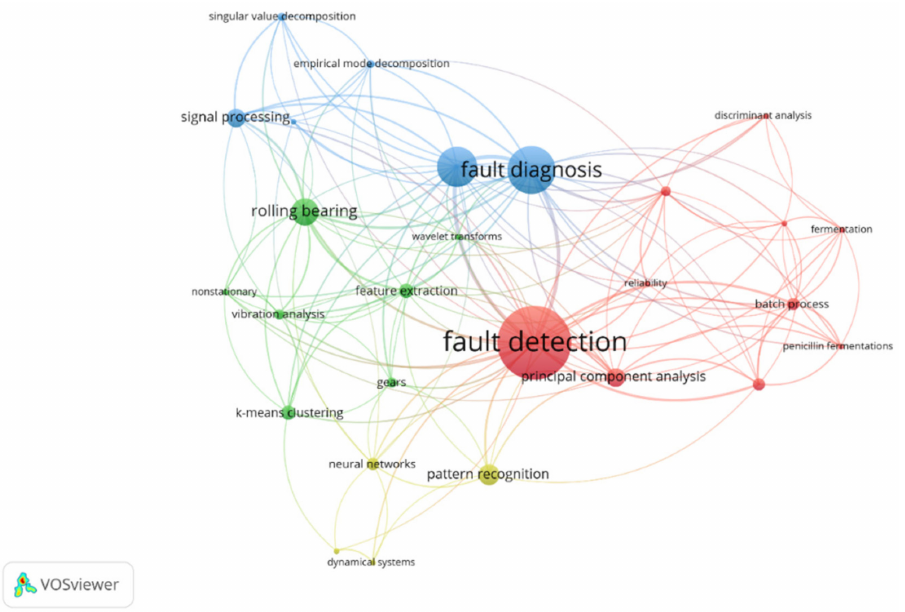
Figure 2. Network visualization.